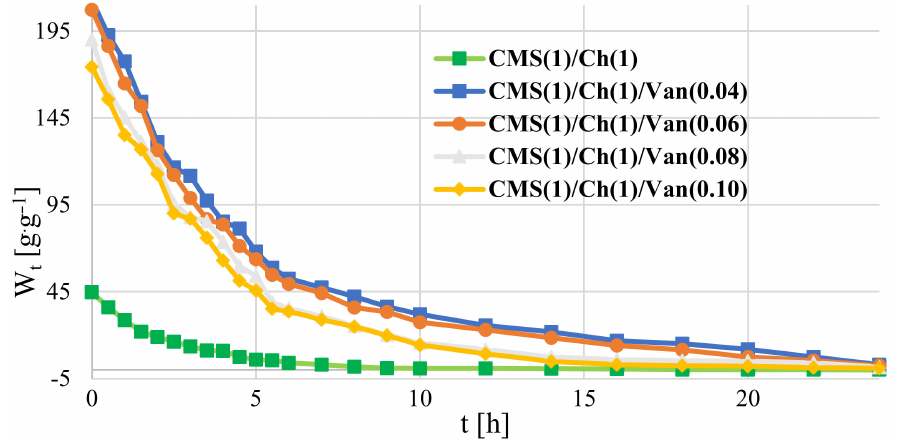
Figure 11. Dehydration kinetics of hydrogels at 50 ◦